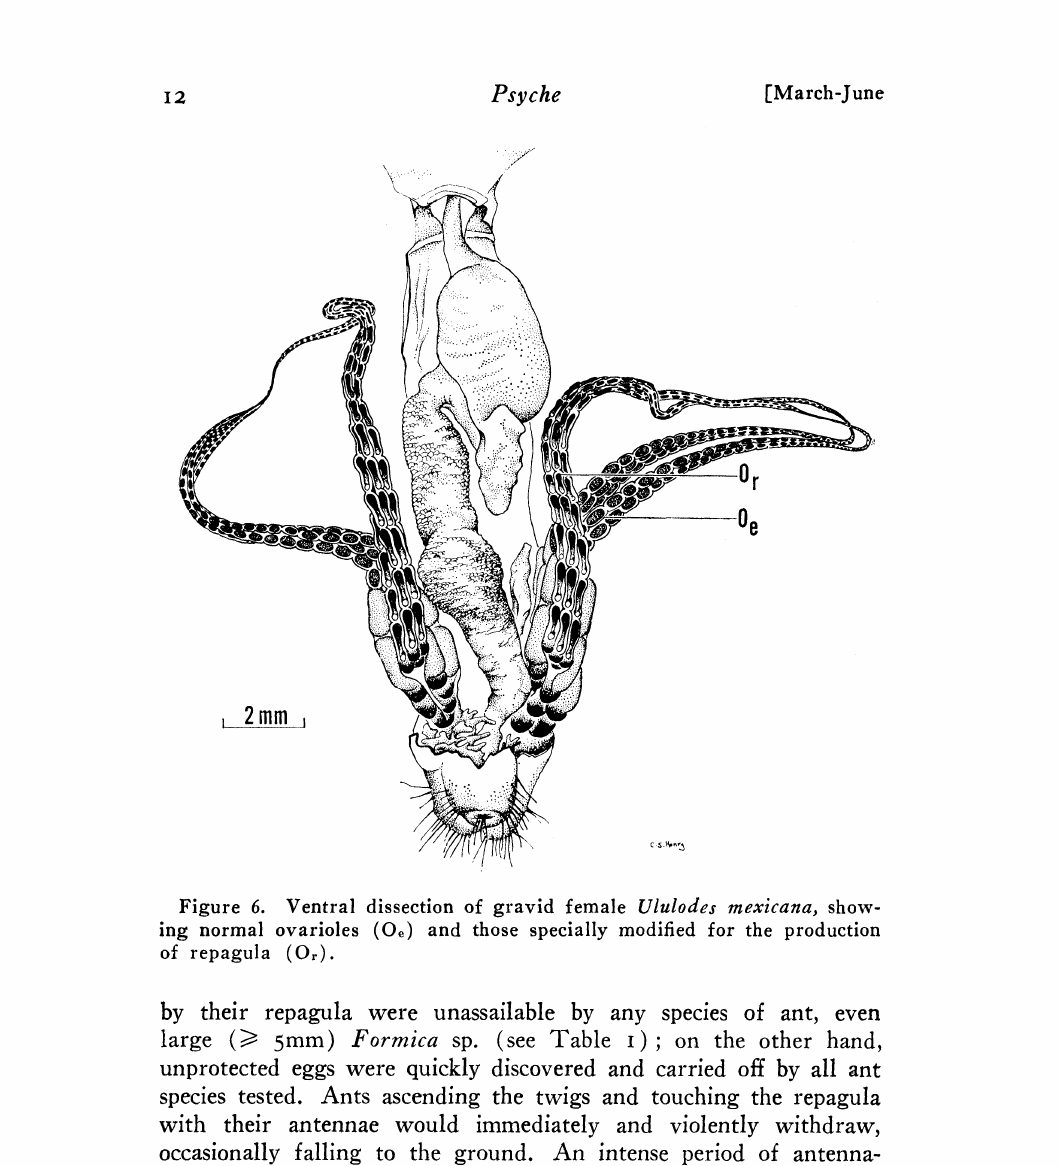
Figure 6. Ventral dissection of gravid female Ululodes mexicana, show- ing normal ovarioles (Oe) and those specially modified for the production of repagula